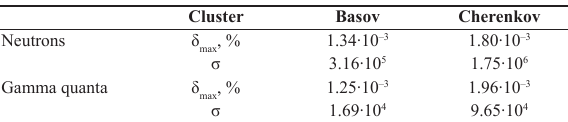
Table 7. ODETTA computation characteristics using one